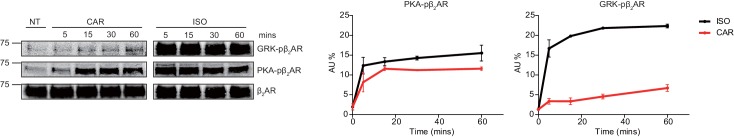
GRK-phosphorylation of β2AR at different carvedilol treated times.HEK293 cells stably expressing FLAG-tagged β2AR were stimulated by 1 μM isoproterenol (ISO) or carvedilol (CAR) for indicated times. Cell lysates were analyzed for PKA-phosphorylated β2AR, GRK-phosphorylated β2AR, total β2AR by western blot. P values are computed by one-way ANOVA followed by Tukey’s test between NT and other groups. Data are the mean ± s.e.m. of four experiments.